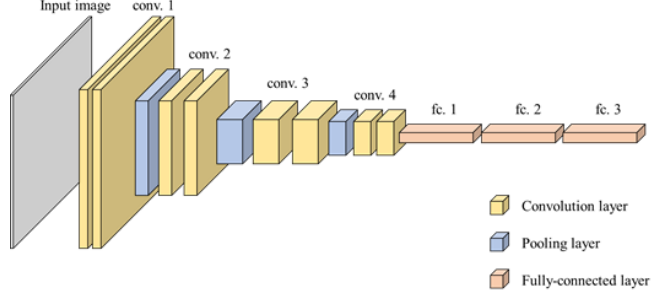
Figure 1. Composition of the convolution neural network.